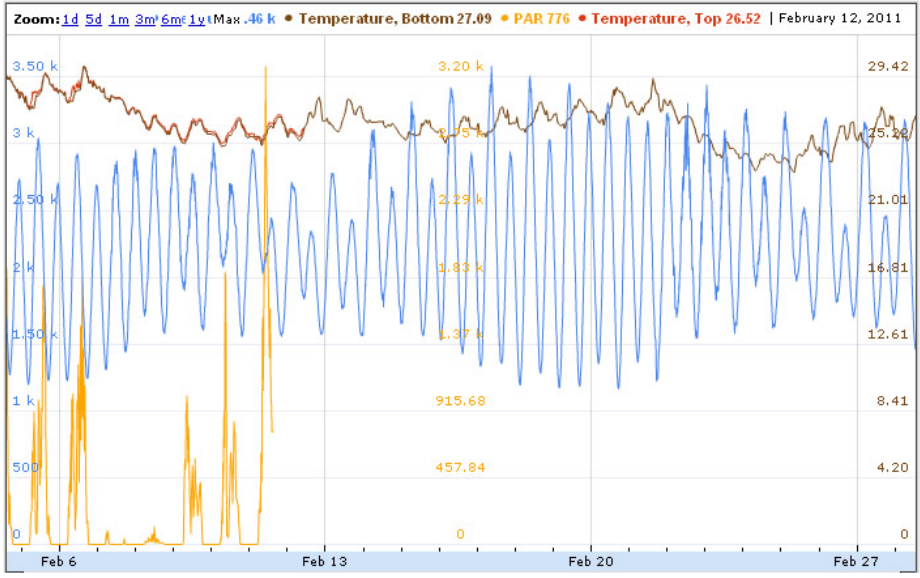
Figure 14. Data collected from one of the SEMAT Mk2 buoys at Deception